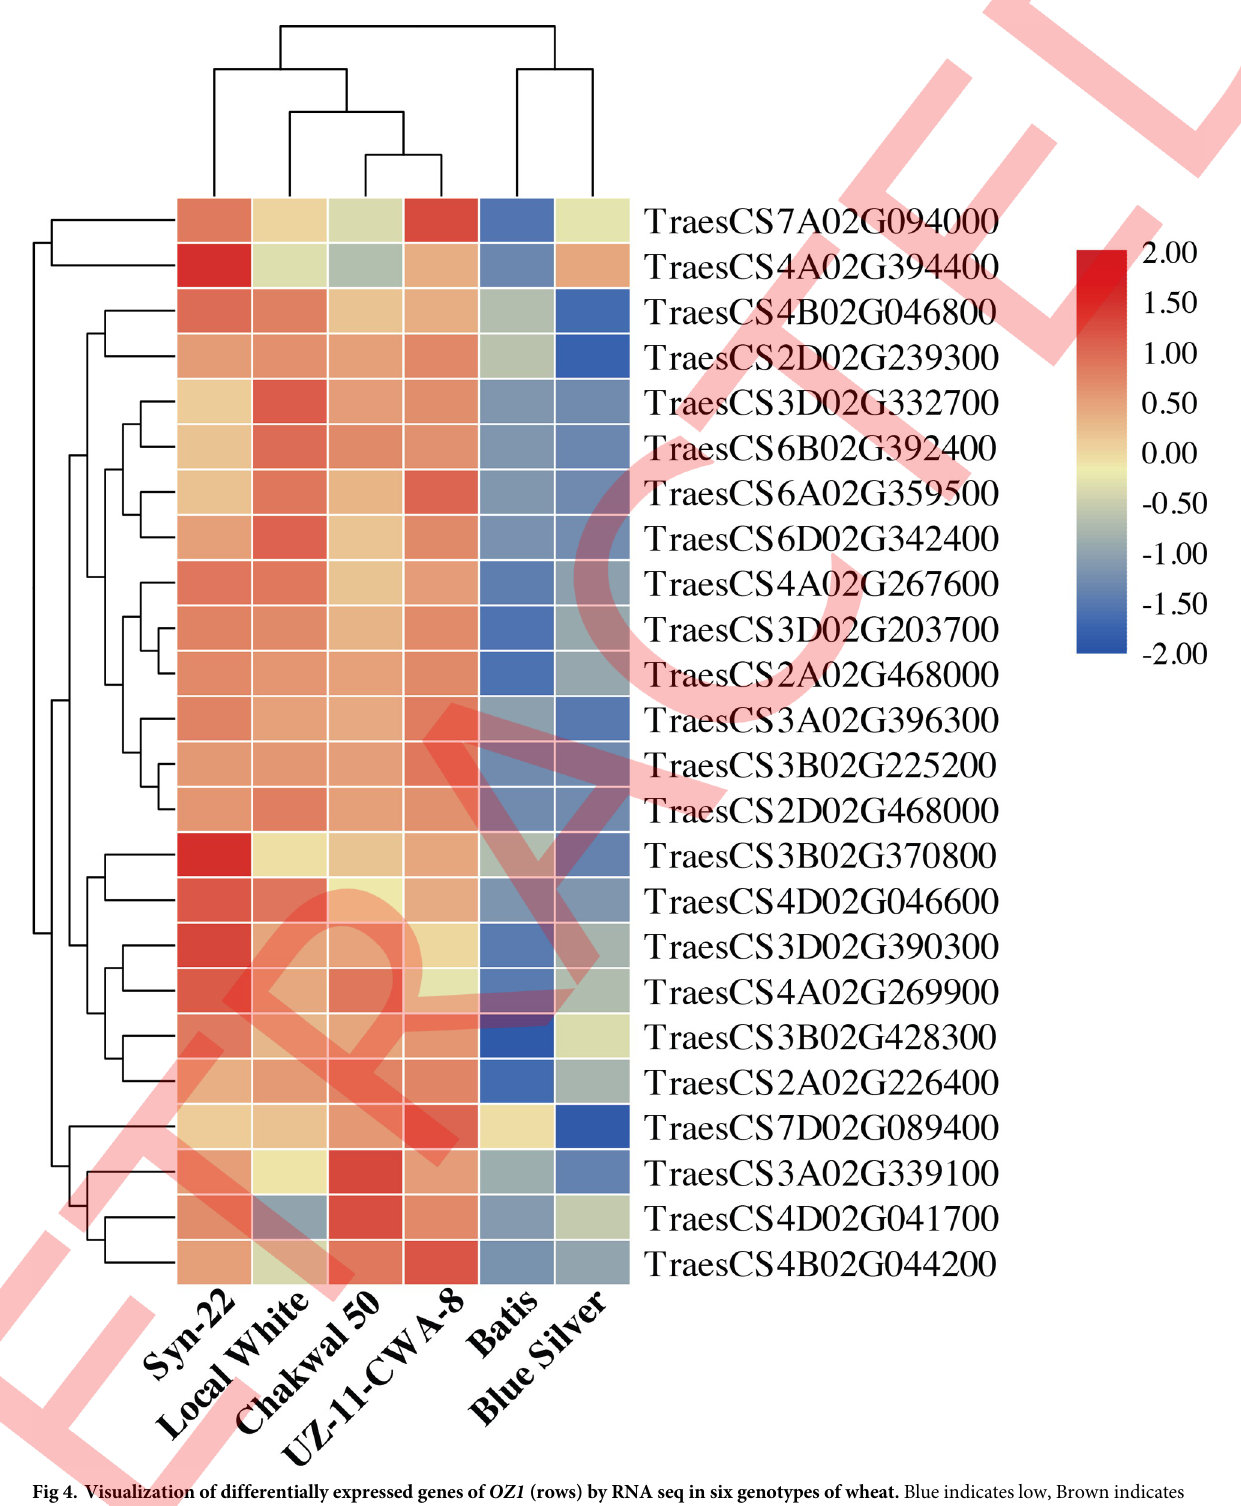
PLOS ONE | https://doi.org/10.1371/journal.pone.0265270 March 11,